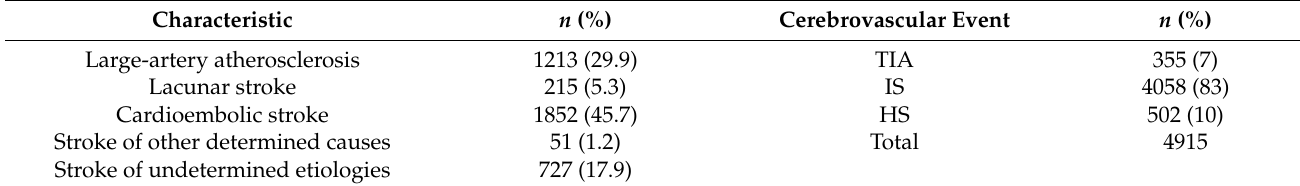
Table 2. Incidence of TIA, IS, and HS and frequency of stroke subtypes using the TOAST classification.